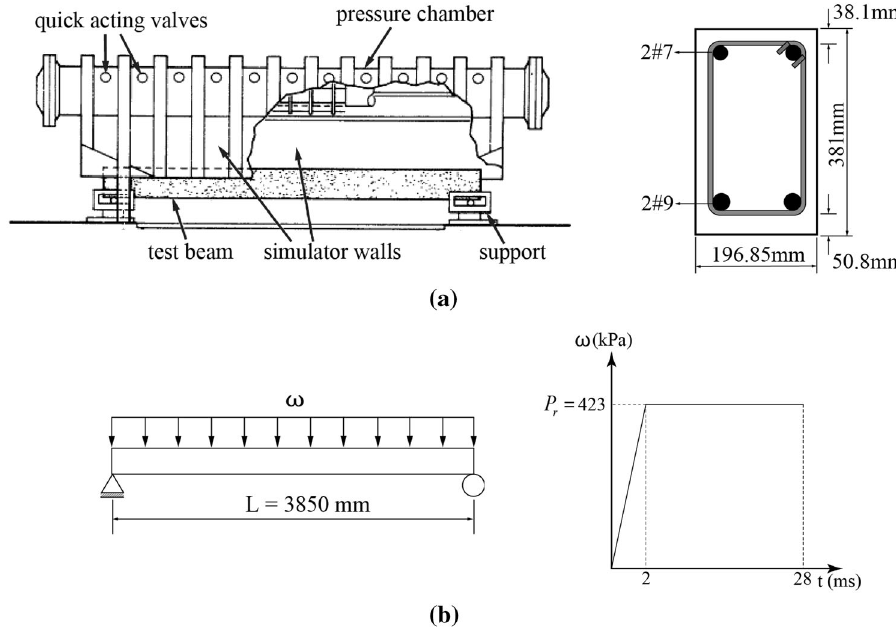
Fig. 9 Geometry and loading history for WE2, WE5, and WE6 (Seabold 1967). a Experimental setup and section details and b configuration of WE2, WE5, and WE6 and blast